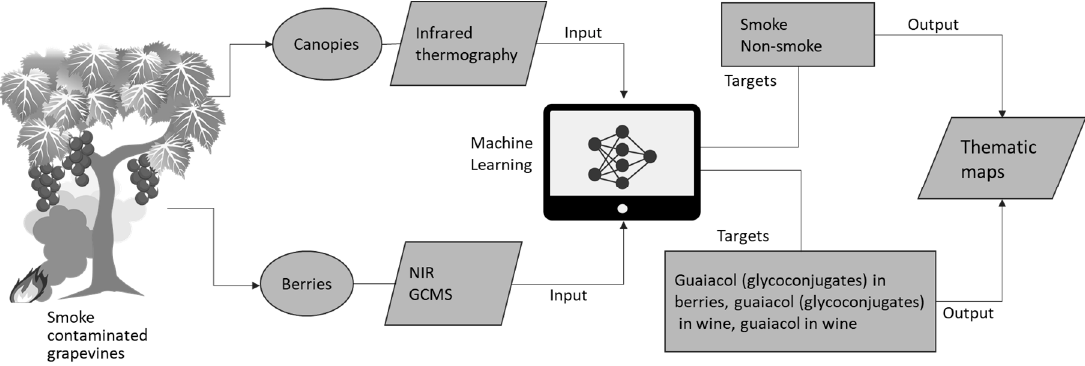
Figure 9. Diagram showing the implementation of machine learning modeling strategies proposed in this paper for proximal (using smartphones and portable infrared thermal cameras and NIR devices) and mid-distance remote sensing using unmanned aerial system (UAS) platforms.